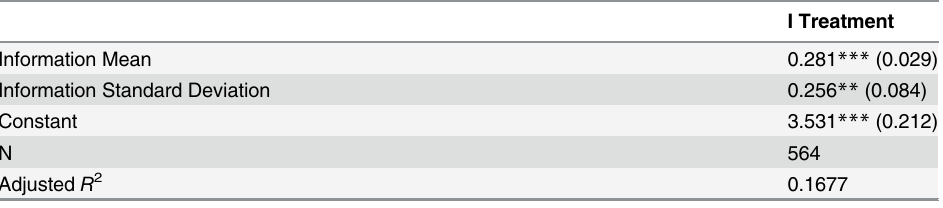
Table 2. Relevance: Are Potential Instruments Correlated with